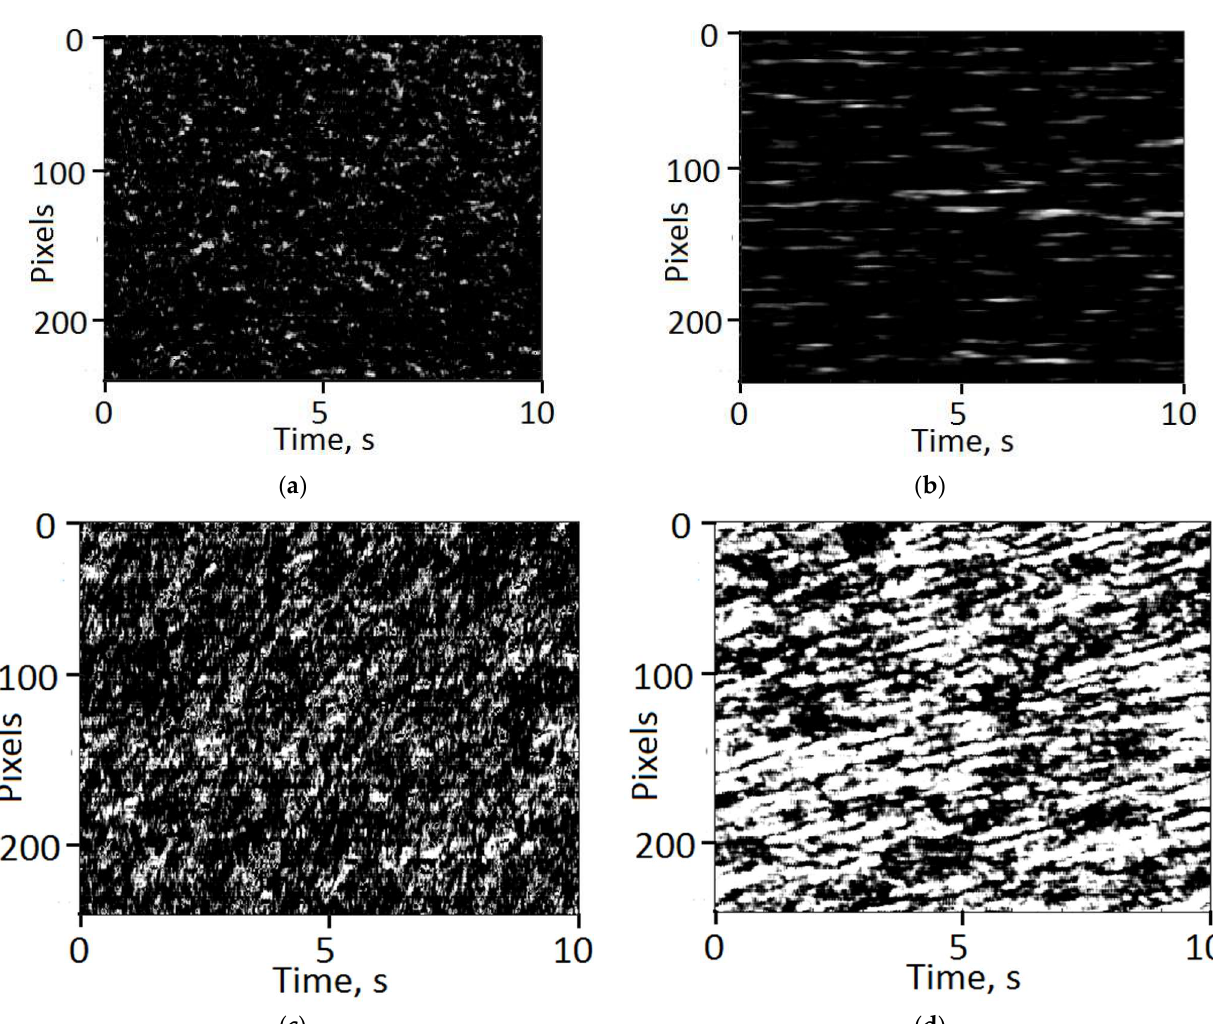
Figure 8. Examples of the recovered SSH maps in the cases of rapid ( a , b ) and slow ( c , d ) pressure release.